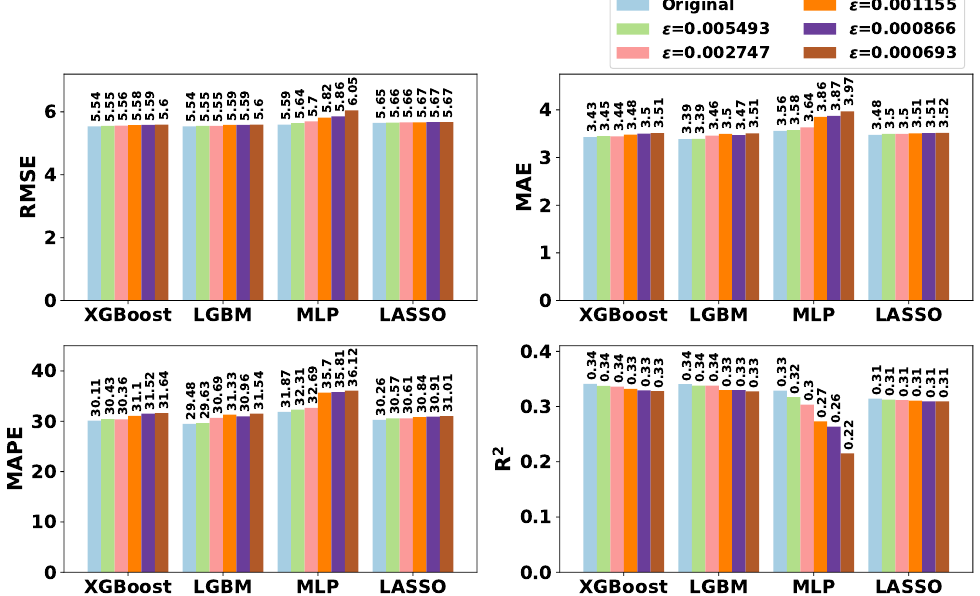
Figure 4. Impact of the level of (cid:101) -geo-indistinguishability for each ML model to predict ART according to each metric.